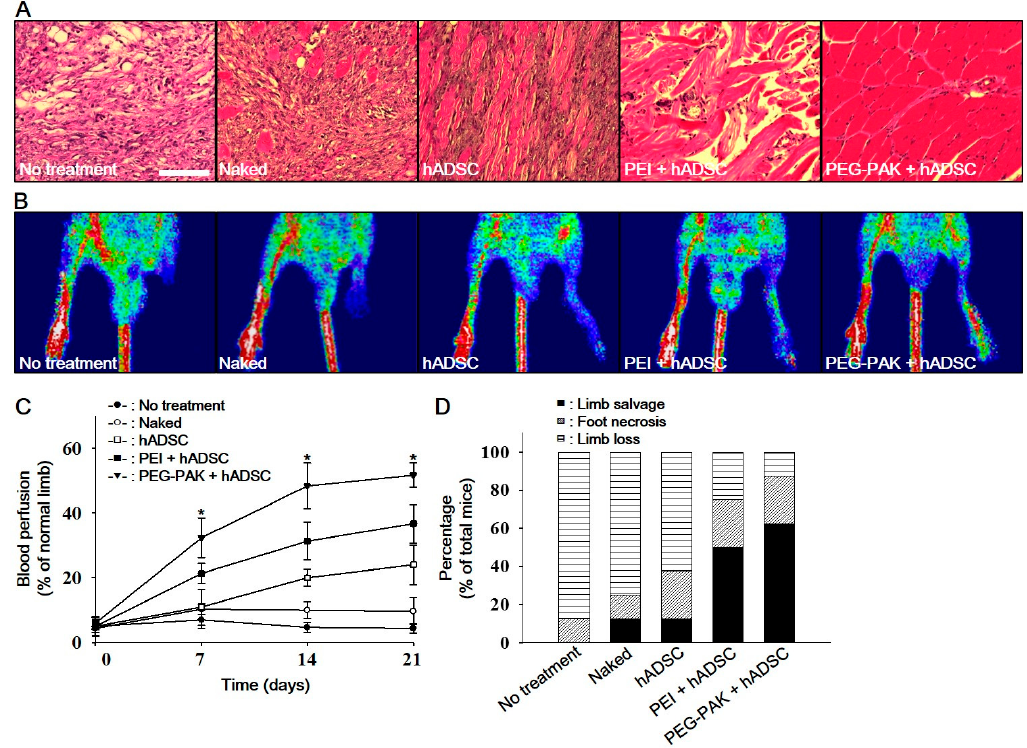
Figure 4. ( A ) Hematoxylin and eosin staining of hindlimb tissues obtained 21 days after ischemic injury (scale bars indicate 100 µ m). ( B ) Representative laser Doppler perfusion imaging analysis performed at 21 days after treatment. ( C ) Blood perfusion of ischemic limbs relative to that of normal limbs at 0, 7, 14, and 21 days after treatment (* p < 0.01 compared with other groups). ( D ) Percentage of mice displaying limb salvage at 21 days after treatment.